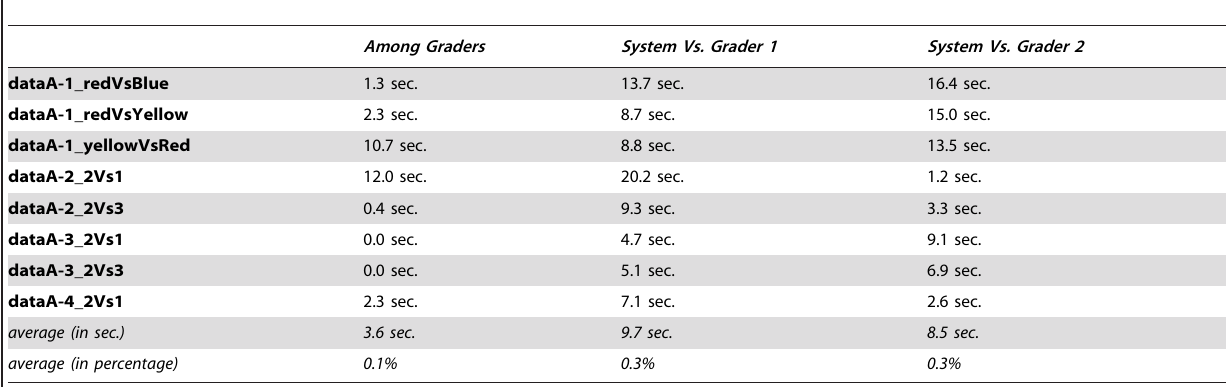
Table 3. Average time difference (in seconds) between the overall duration of each behaviour as classified by the graders or by the system (less is better).